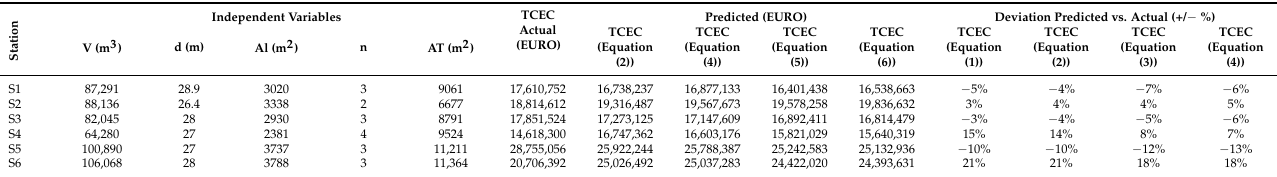
Table 8. Validation calculations for cost prediction